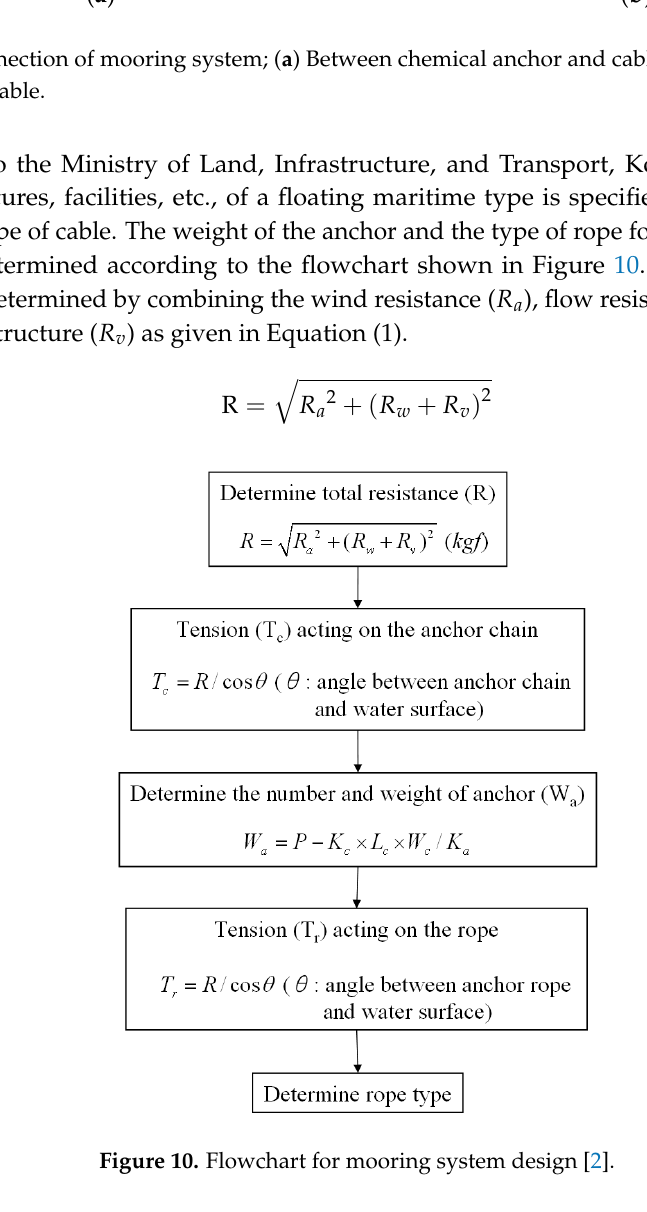
Figure 10. Flowchart for mooring system design [2].